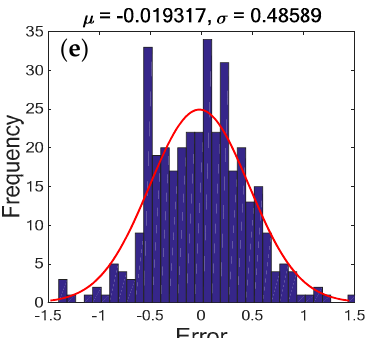
Figure 8. Error histogram of the best composite models (( a ) BRT, ( b ) MLPNN, ( c ) RBFNN, ( d ) MARS, and ( e ) KELM; UC Riverside station).